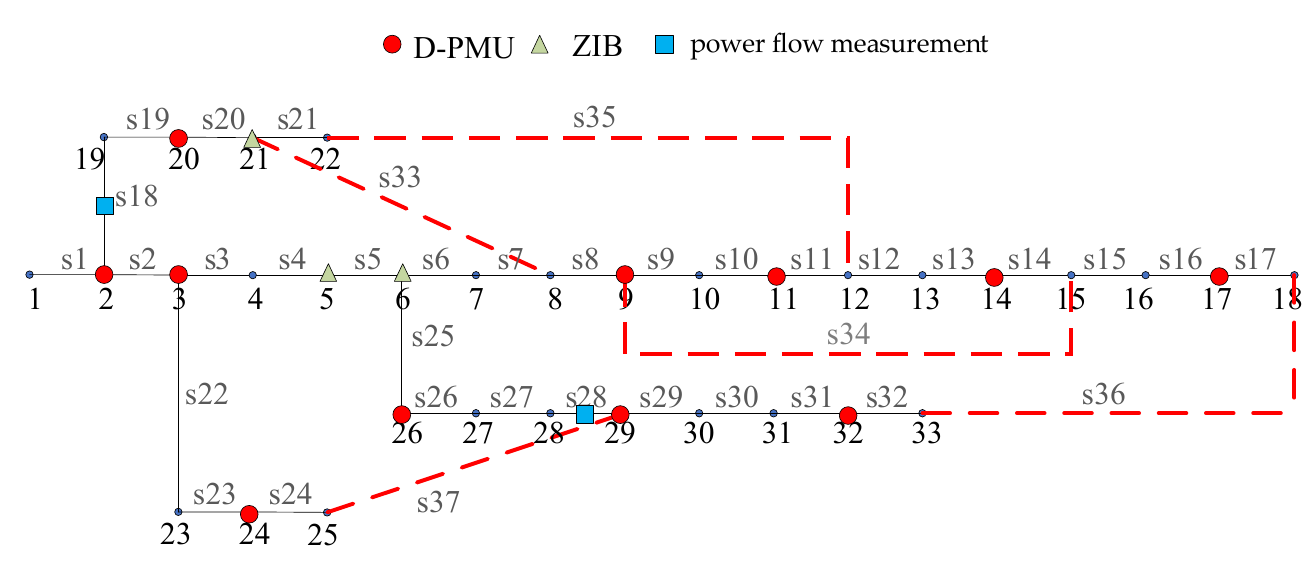
Figure 5. Results of D-PMU placement for IEEE 33-bus system.